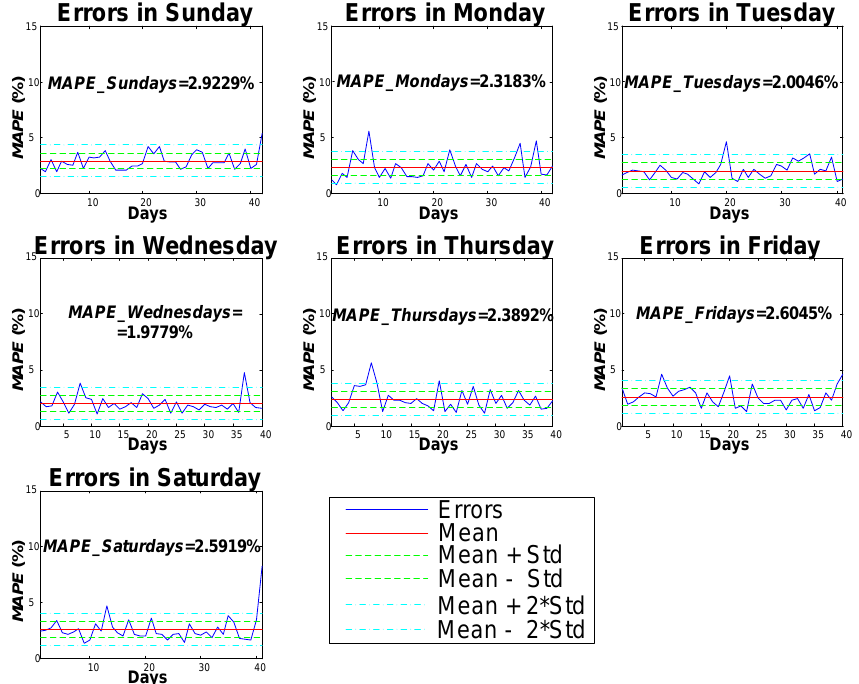
Figure 12. Errors per day. The y-axis represents the forecast error by Equation (1). The x-axis represents each of the forecast days.